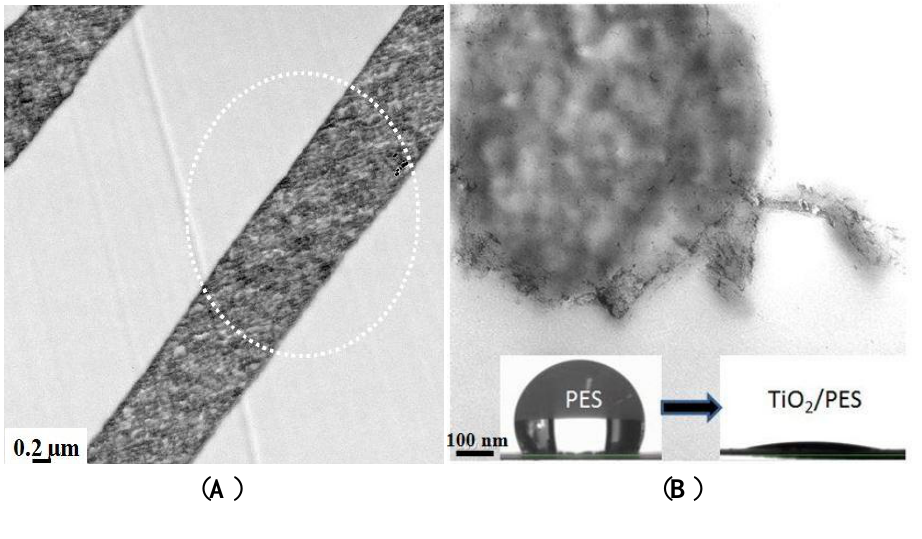
Figure 13. TEM observation of ( A ) ZrO (adjacent to a bead with the same composition) (the inset picture implies the superhydrophilicity effect of the composite nanofibrous membrane)